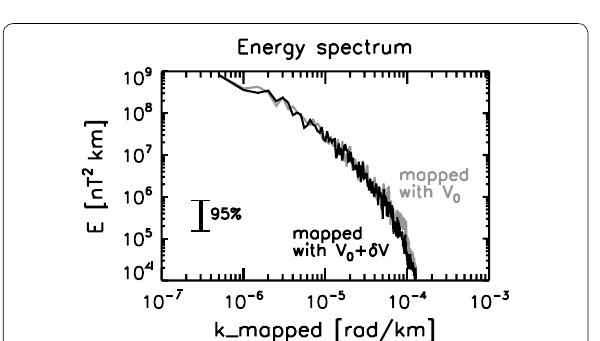
Fig. 3 Energy spectrum (trace of the spectral density matrix) of the mapped magnetic field data (onto the spatial coordinates) in the streamwise wavenumber domain. The spectrum using the total flow velocity is represented in black and that using the mean constant flow velocity is in